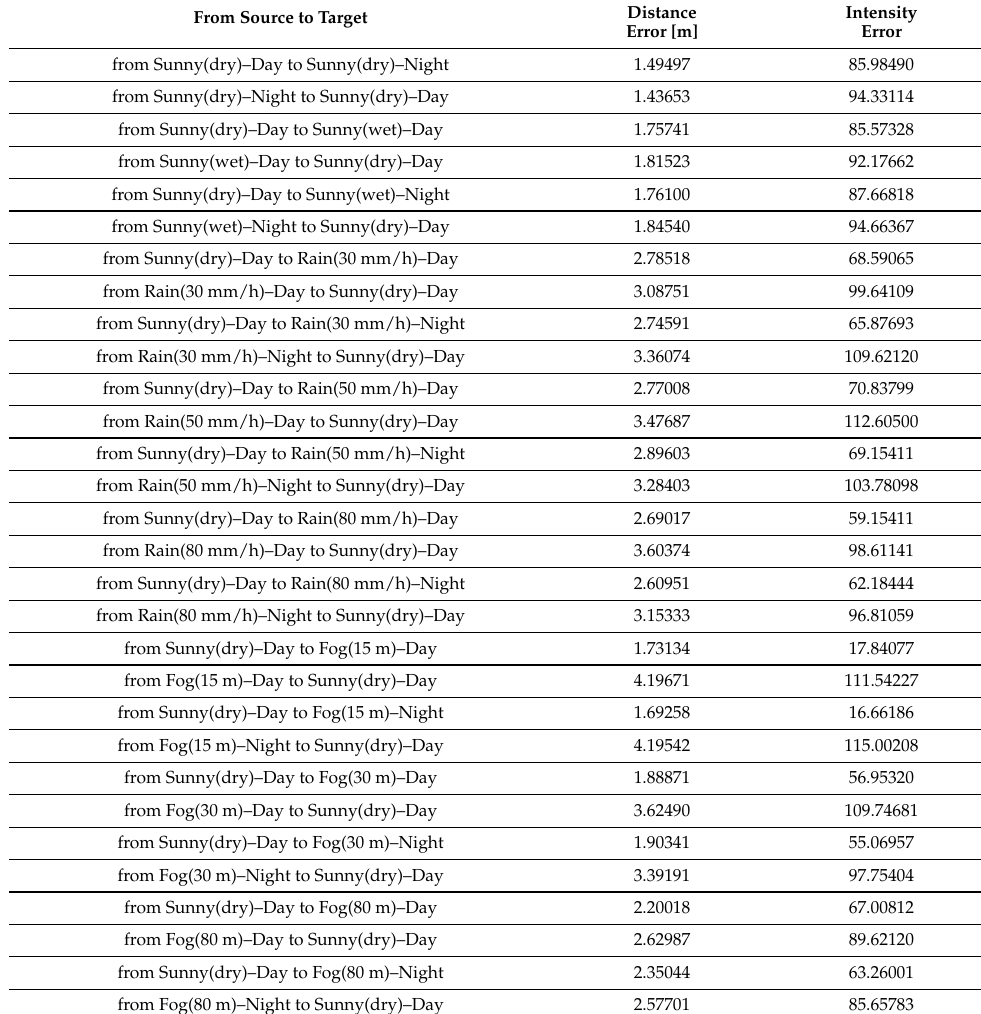
Table 6. Translation results under various conditions with the JARI data